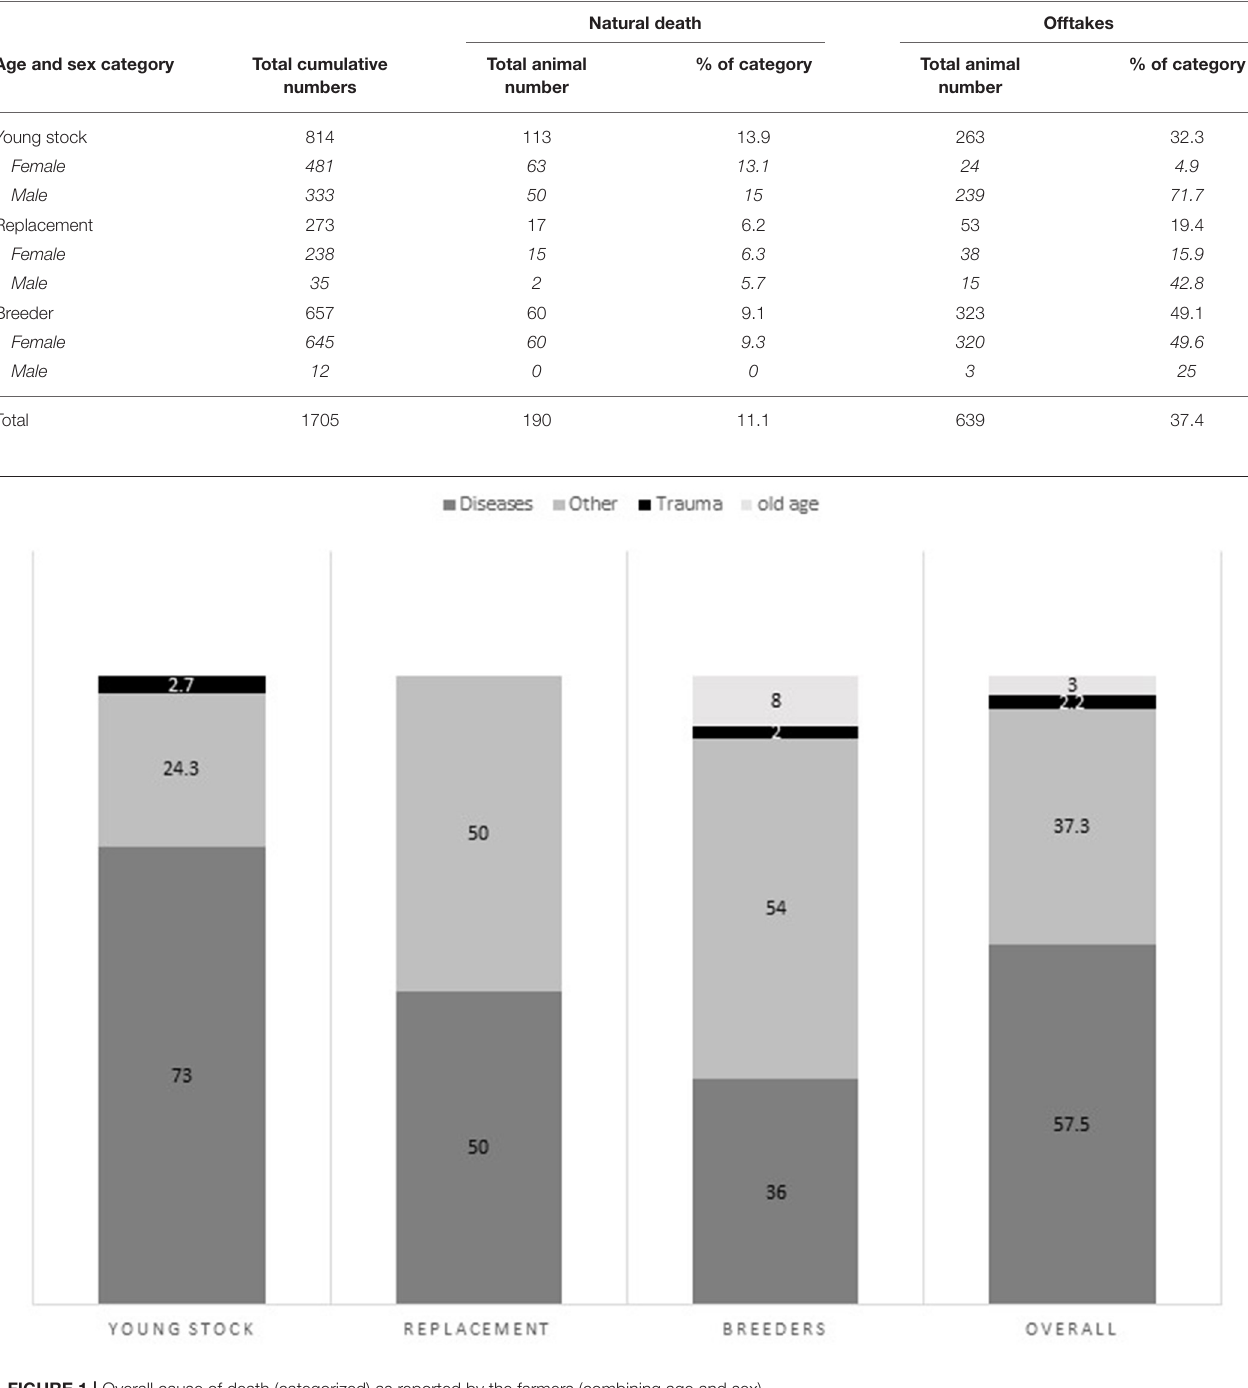
FIGURE 1 | Overall cause of death (categorized) as reported by the farmers (combining age and